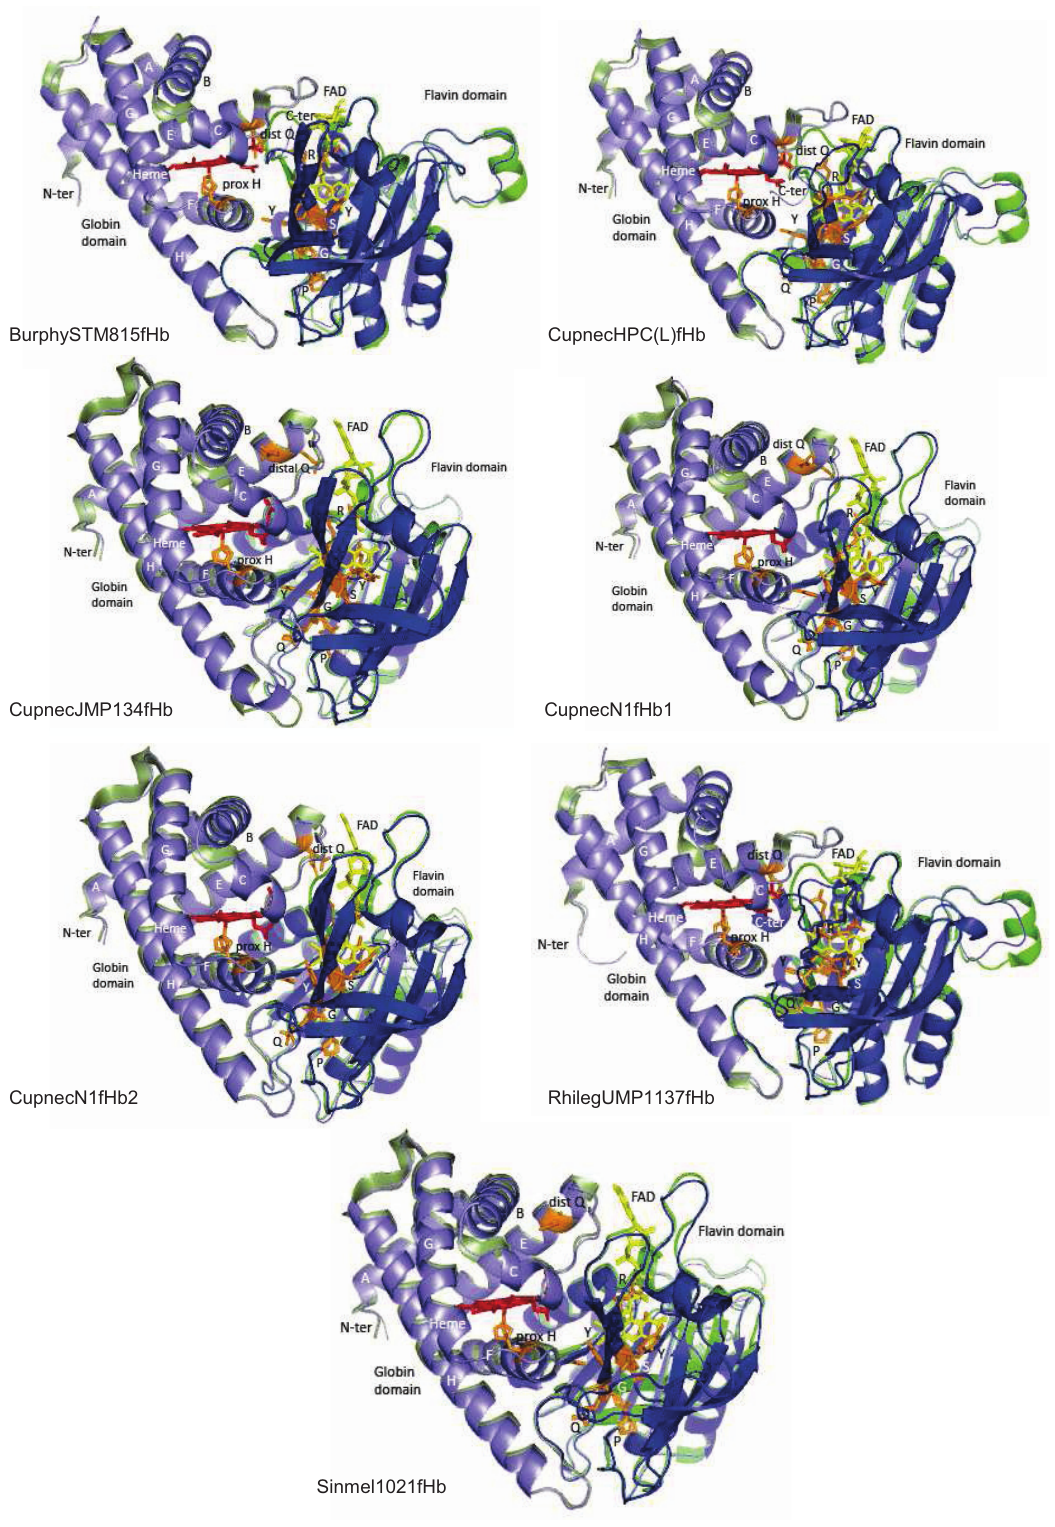
Figure 3. Predicted structure of rhizobial fHbs (blue) overlapped to structural homologues (green). Structural homologues are indicated in Dataset 3. Distal and proximal amino acids to the heme Fe and amino acids that interact with the FAD cofactor are shown in brown. Heme and FAD are shown in red and yellow, respectively. Helices within the globin domain are indicated with letters A to H. All structures are displayed in the same